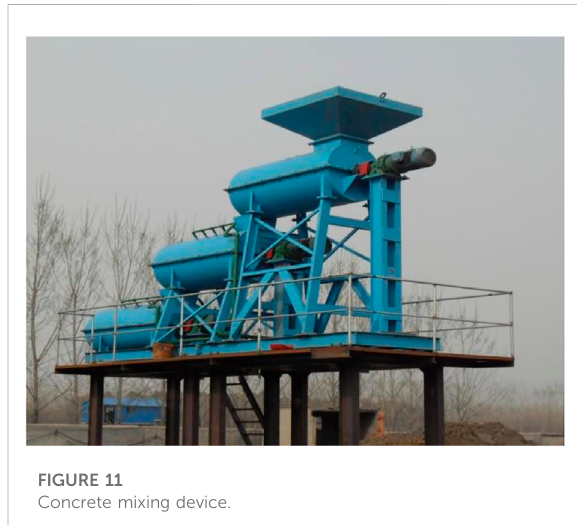
FIGURE 11 Concrete mixing